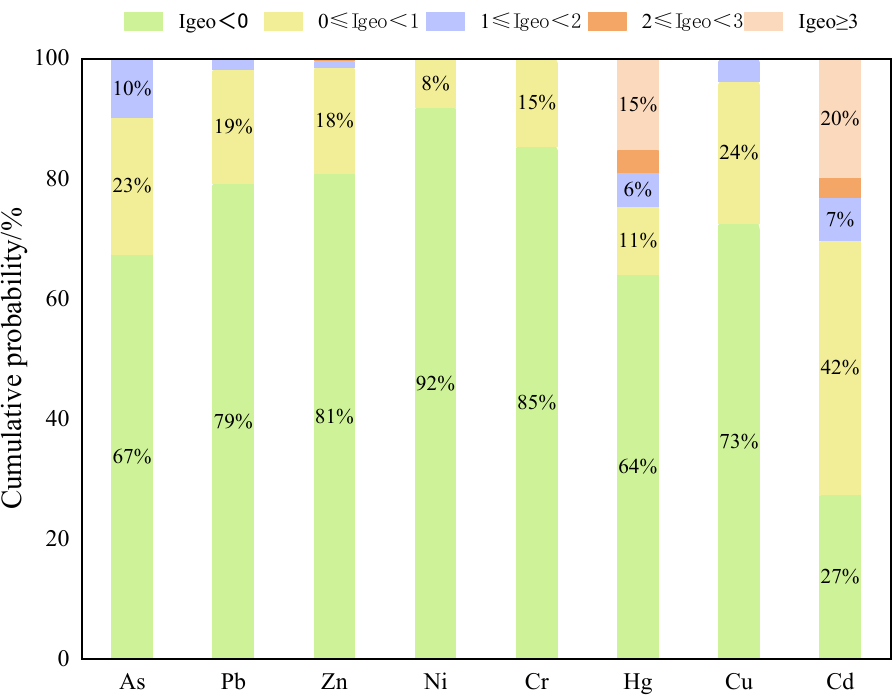
Figure 4. Evaluation of the accumulation index of heavy metals in the sediments of the Weihe River Basin.